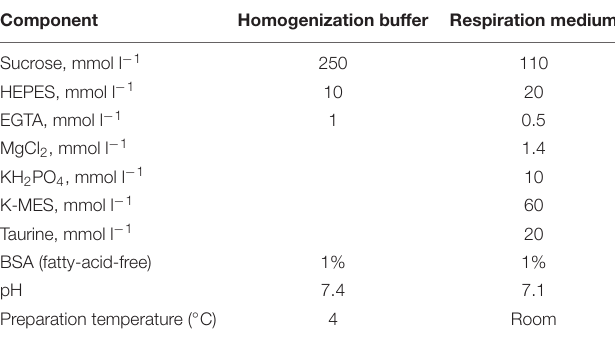
TABLE 1 | Composition of solutions used for mitochondrial isolation and measuring